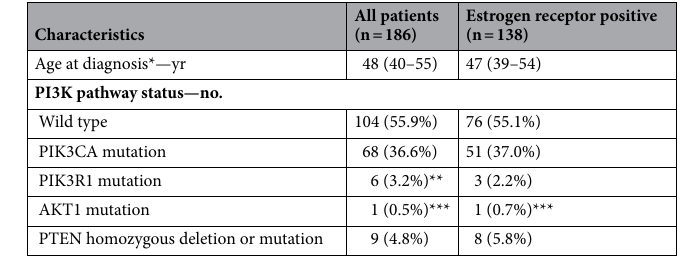
Table 1. Characteristics of the patient cohort selected from Razavi et al. 23 . *Shown as median (first and third quartiles). **One patient has both PIK3CA and PIK3R1 mutations. ***One patient has both PIK3CA and AKT1